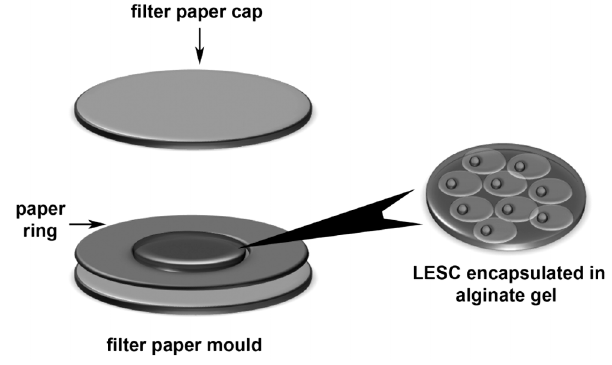
Figure 2. Schematic of LEC encapsulation in alginate gels. To form alginate gel discs, a paper ring with a 2 cm diameter opening is placed over a 3 cm diameter paper disc, and saturated with 102 mM CaCl 2 before alginate solution (420 m L) was pipetted into the ring. A second 3 cm diameter paper disc saturated with 102 mM CaCl 2 was placed over the alginate/paper assembly. Alginate solutions were exposed to 102 mM CaCl 2 for 10 min to allow complete gelation. Dimensions of calcium alginate gel masses and discs. Calcium alginate gel discs are approximately 19 mm in length and 1.5 mm in